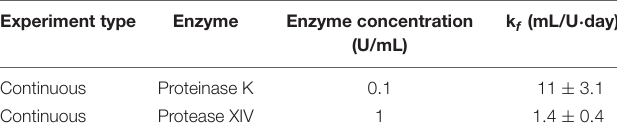
Water Annealing Time: 2